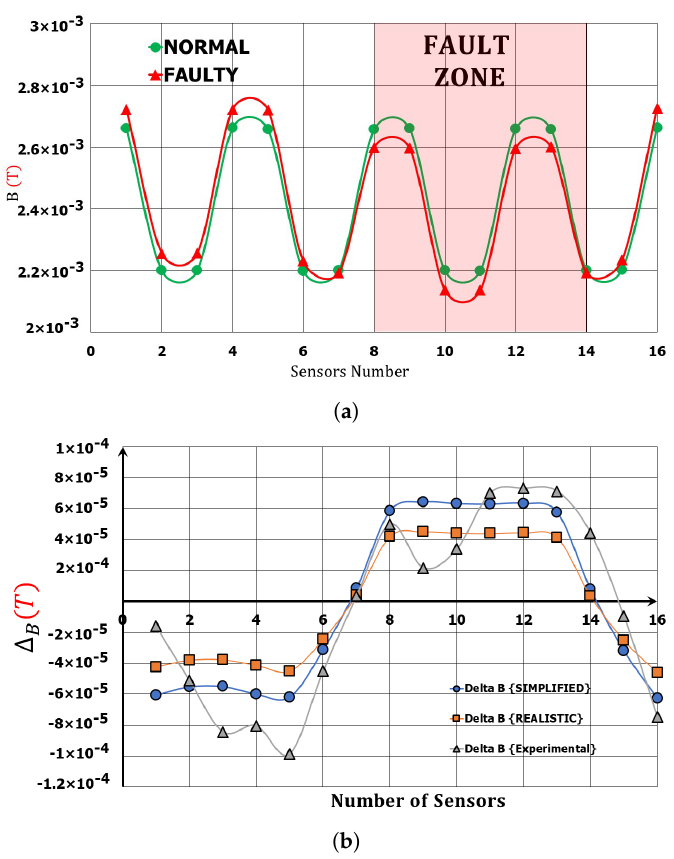
Figure 12. ( a ) Simulated simplified model in normal and faulty behaviors of the 3rd cell, ( b ) ∆ B simulation (simplified and realistic) and experimental at the level of the 3rd